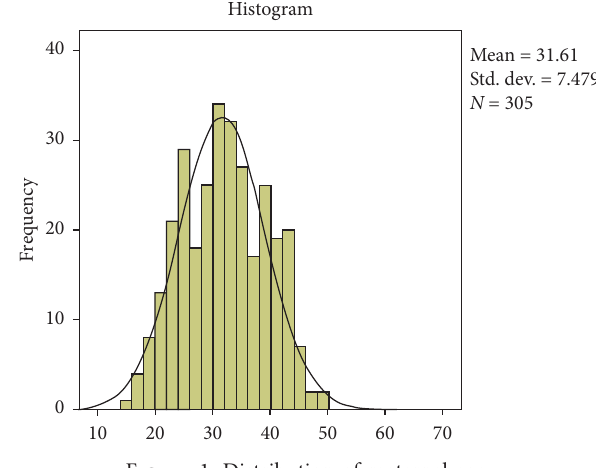
Figure 1: Distribution of maternal age.